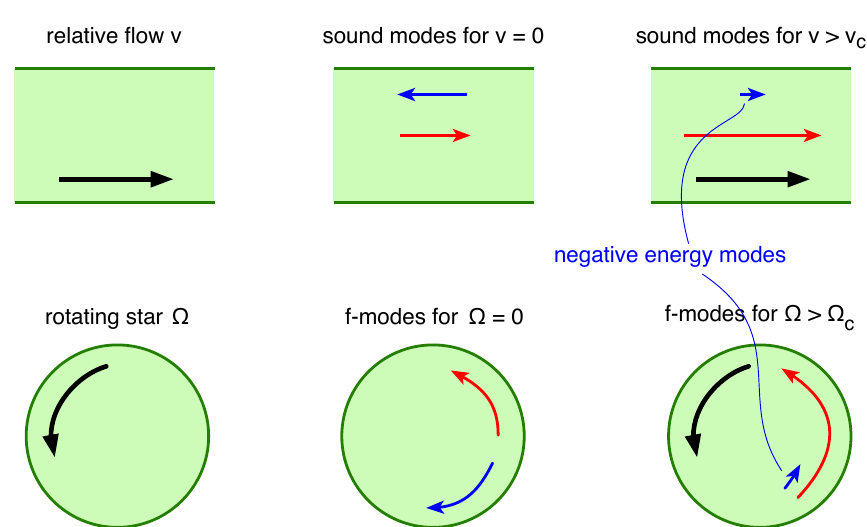
Figure 1. Analogy between the two-stream instability ( upper row , discussed in this paper), and the Chandrasekhar-Friedman-Schutz (CFS) instability in neutron stars, here schematically shown for f -modes ( lower row ). Left column : The thick (black) arrow indicates the relative velocity v of the second fluid, viewed in the rest frame of the first fluid, or the rotation of the star with frequency Ω , viewed from an inertial frame. Middle column : In the absence of a relative motion of the fluids or a rotation of the star, a given mode can propagate with the same speed in two opposite directions, indicated by two thin (red and blue) arrows of the same length. Right column : At a sufficiently large counterflow between the fluids or a sufficiently large rotation frequency of the star, one of the modes flips over. This point marks the onset of an energetic instability. In astrophysics literature, instabilities indicated by negative energies are often referred to as “secular instabilities” [45,46]. If the system is now allowed to interact with its environment by dissipative effects (both cases) or losing angular momentum through the emission of gravitational waves (star), the energetic instability turns